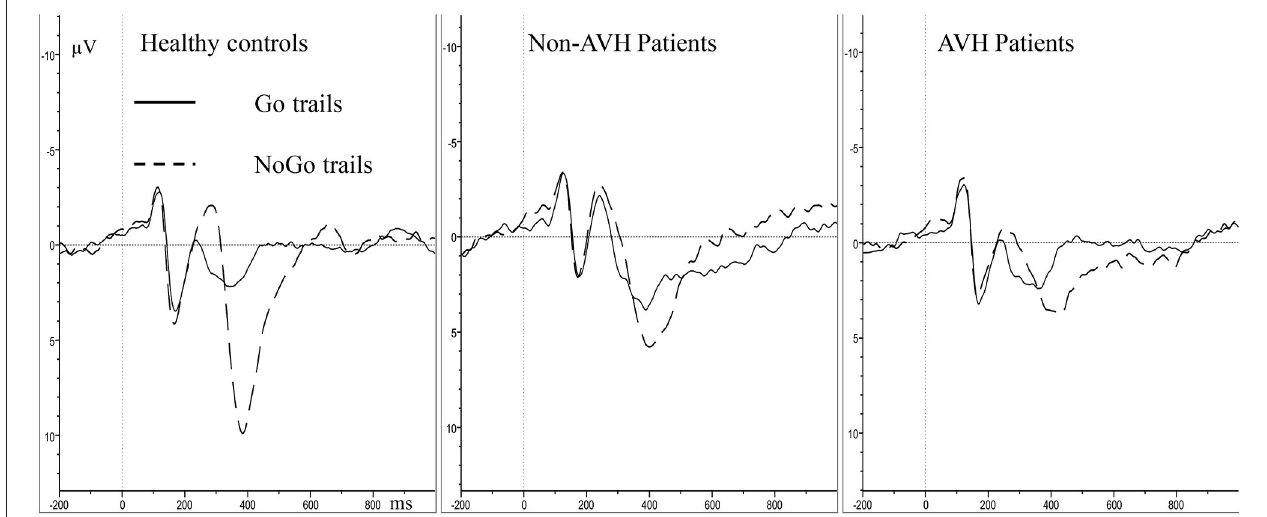
FIGURE 3 | Averaged waveforms at Fz in Go and NoGo